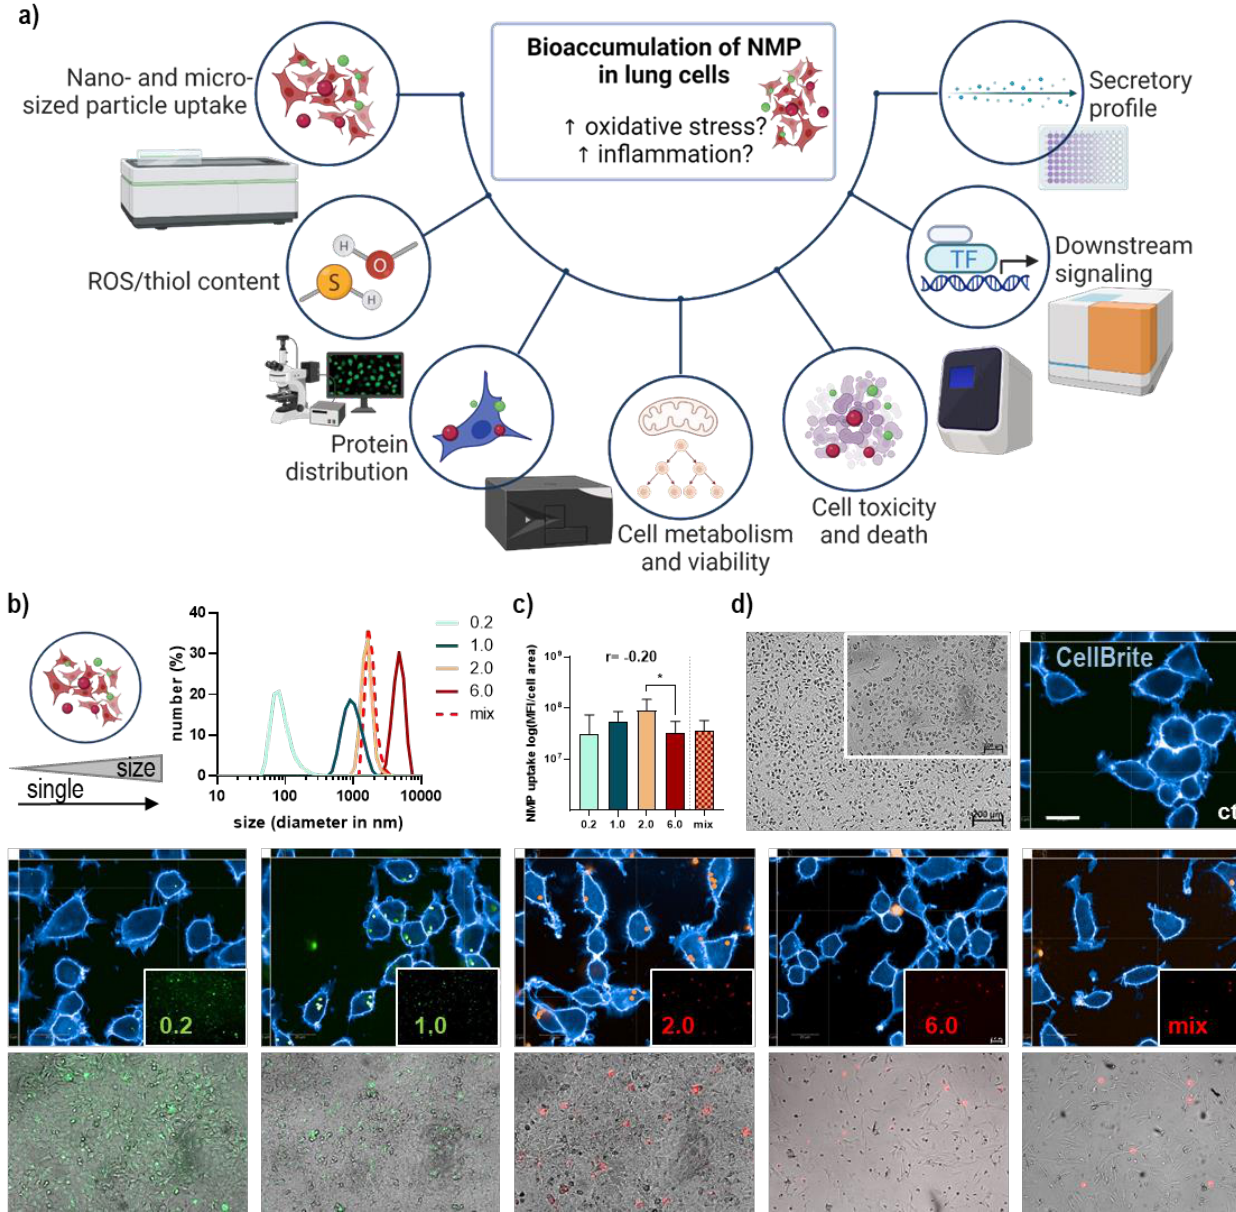
Figure 1. Methods and algorithm-based uptake analysis of fluorescently labeled NMP in lung epithelial cells . ( a ) In plastic-exposed cells, several types of analyses were performed, including NMP uptake determination, secretion profiling, gene and protein expression analysis, high-content imaging, and flow cytometry; ( b ) study scheme (right) and size verification via DLS of several polystyrene NMP with fluorescent labeling ranging from 0.2 µ m to 6 µ m; ( c ) algorithm-based image analysis and calculation of NMP uptake; ( d ) viable lung epithelial cells (mix of primary alveoli and bronchi)